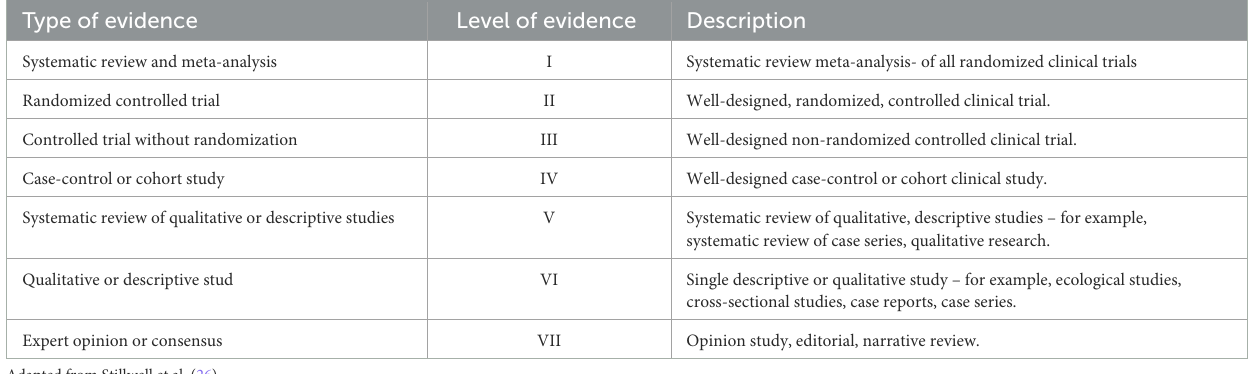
TABLE 2 Categorization of the level of evidence, according to the type of study of the scientific productions.